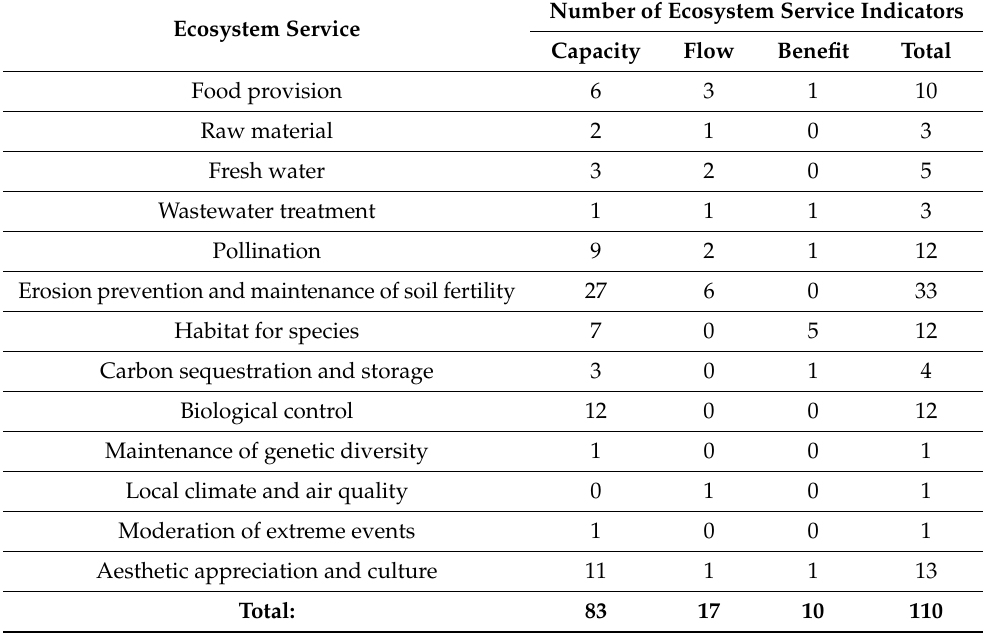
Table 1. Number of ecosystem service indicators as categorised into capacities, flows and